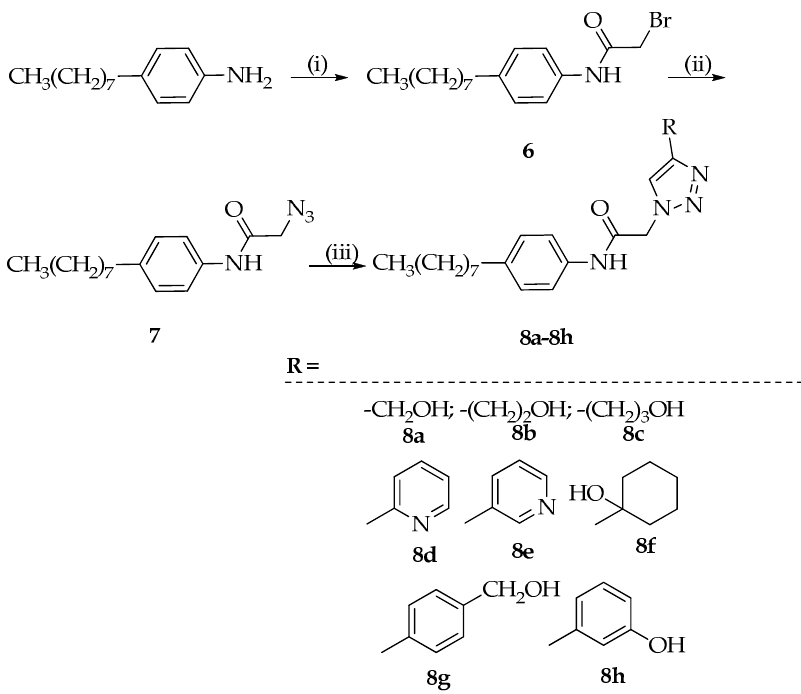
Table 1. Structures of the 1,4-disubstituted 1,2,3-triazoles 5a – h and 8a – h